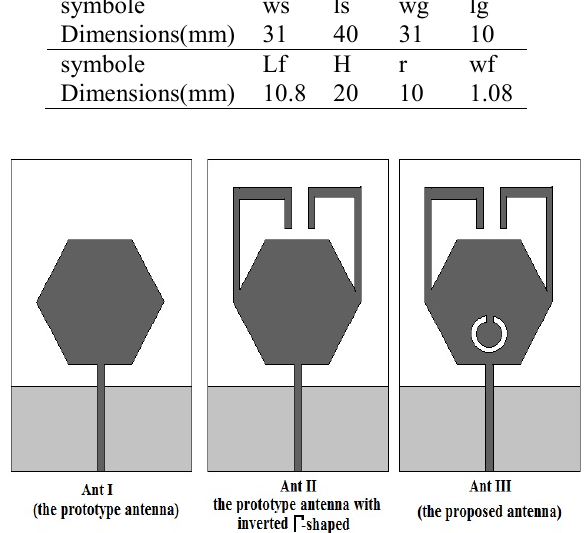
Figure 1: This is the figure Geometry of proposed antenna (a) top view, (b) Bottom view.